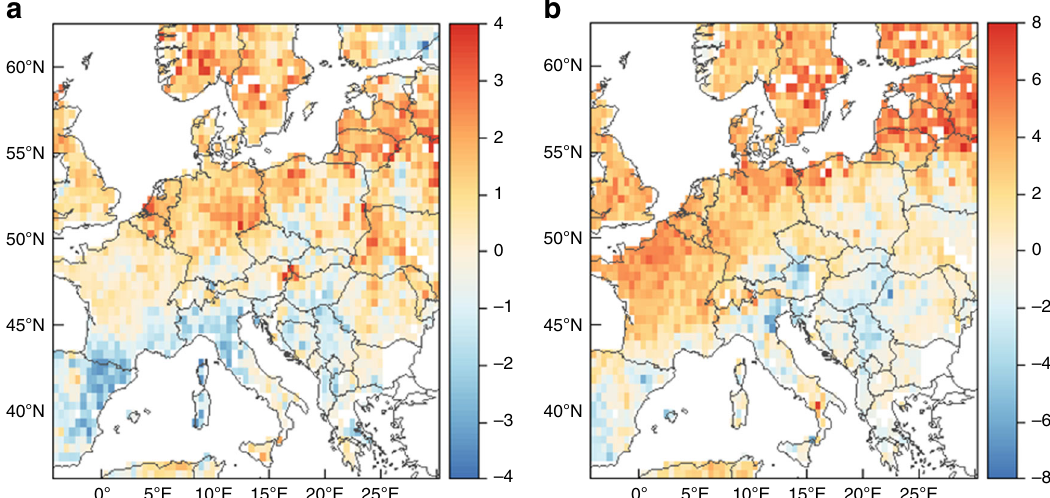
Fig. 6 Logistic regression analysis. Non-linear relationships between 10-year scPDSI and a regional temperature and b seasonal NAO for 1500 – 2012, as presented by the logistic regression coef fi cients as estimated by Eq. 2 (see Methods; positive sign correspond to positive correlation). The corresponding statistical signi fi cance is presented in Supplementary Fig. 4